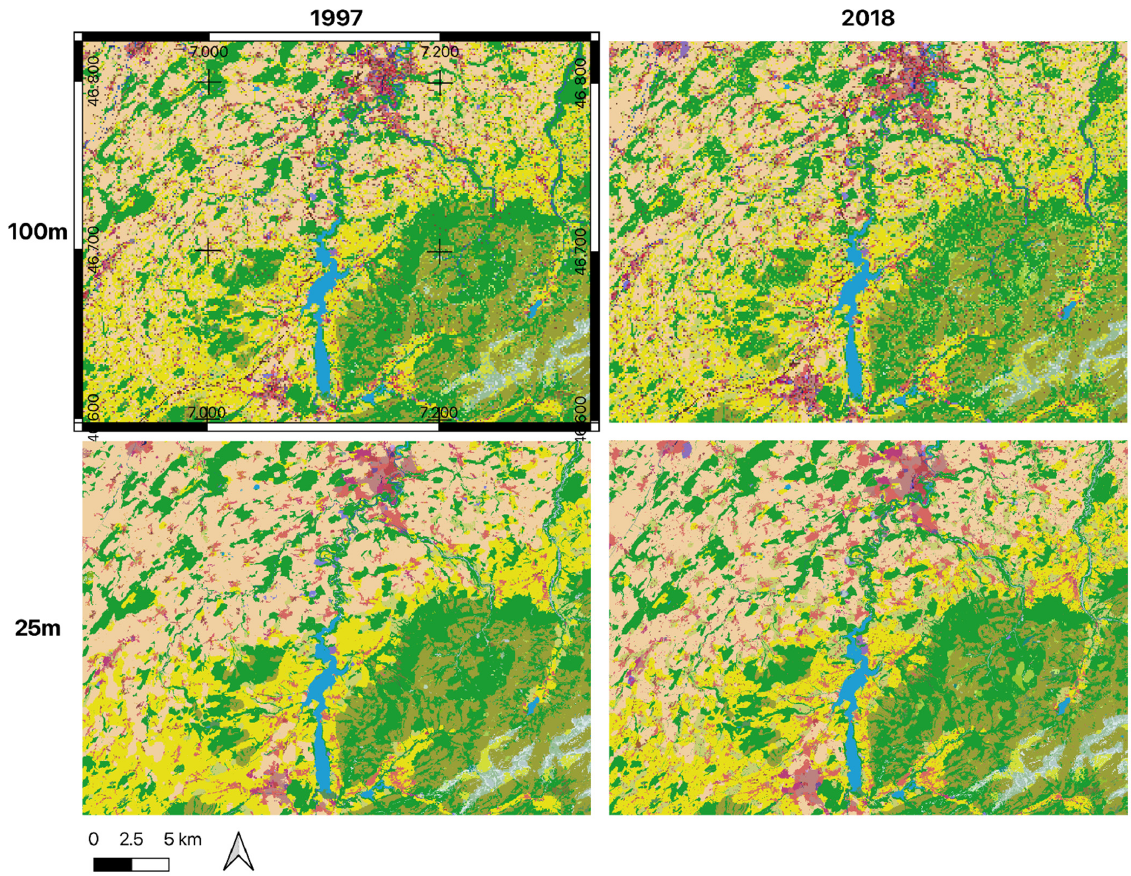
Figure 10. Comparison of the 1997 and 2018 LU/LC data with original 100 m resolution ( above ) and the downscaled outputs at 25 m ( below ) for the Bulle and Freiburg cities. Urban expansion (as well as other land cover changes and the smoothing effect) of this economically active region can be more easily visualized with the improved spatial resolution. The proportion (71%) of exact matches between the land use categories recorded at the 100 m resolution lattice points of the Landuse100 statistics and the corresponding points in the downscaled map (25 m resolution) is particularly encouraging. Discrepancies appear to result mainly from the change in scale and geometric precision brought in by the 1:25,000 base maps. The fundamental difference in approach between the land use statistics (punc- tual) and the topographic map (surface) is also important. A visual check confirms that most divergences mainly occur along boundaries of patches of different land use and along linear and small features. By using an inverse distance calculation—which gives a higher weight to close-by information—to choose the best land use category for each pixel, we greatly fa- vored the retaining of input land use categories at an observed location in the result. This effect can be modulated by the smoothing factor in Equation (2). The approach could be used at even finer scales by rasterizing for instance the topo- graphic maps at 10 m instead of 25 m or using a regional map at a finer scale (1:10,000). Getting accurate land use information is crucial for calculating landscape indices such as those obtained from FRAGSTAT [107]. As demonstrated by Uuemaa et al. [108], changing grain size can have a significant effect on many landscape metrics. Therefore, one should pay attention to the scale at which a given landscape metric is calculated, and what grain